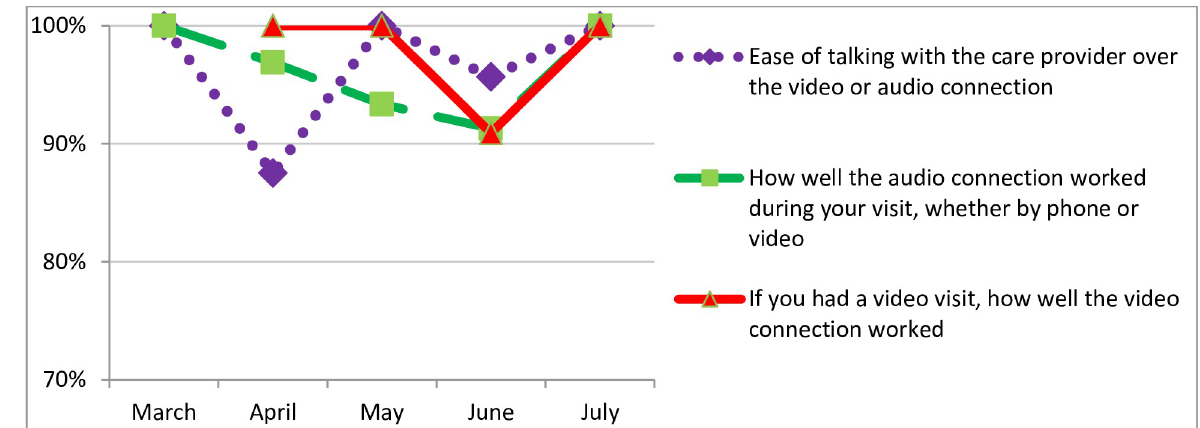
Fig 2. Graph showing the frequency of trop box score of 4 or 5 by month for telenephrology responses. Graphical illustration of satisfaction of audio, video and overall ease of communication with providers by survey month.